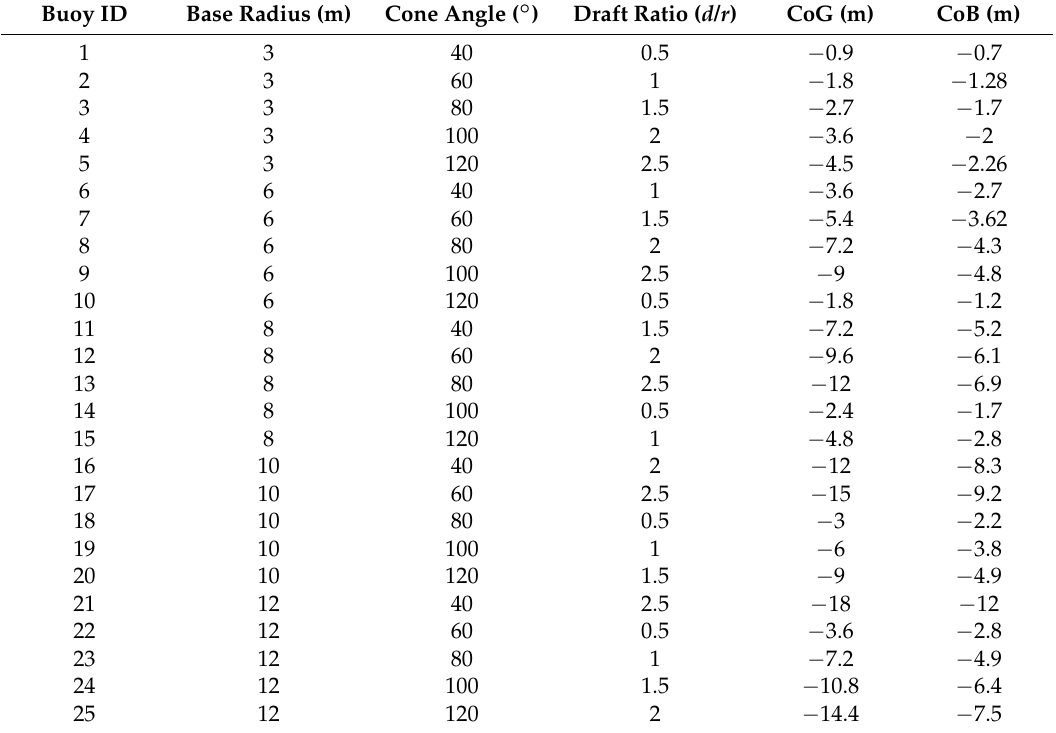
Table 4. Candidate buoy